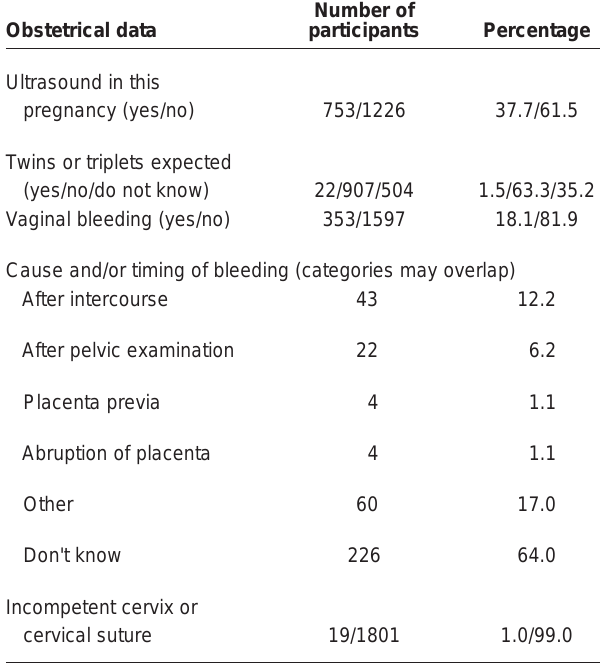
TABLE 6 Obstetrical history of participants in the Edmonton Perinatal Study